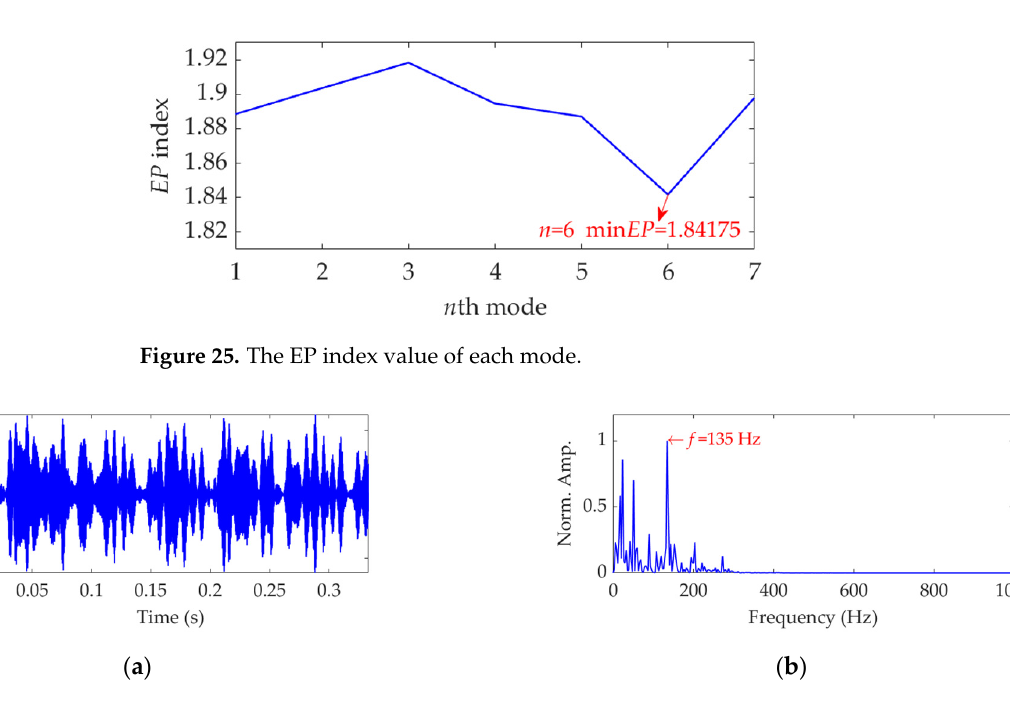
Figure 24. Results of the vibration dataset associated with the ball fault obtained using SVMD with